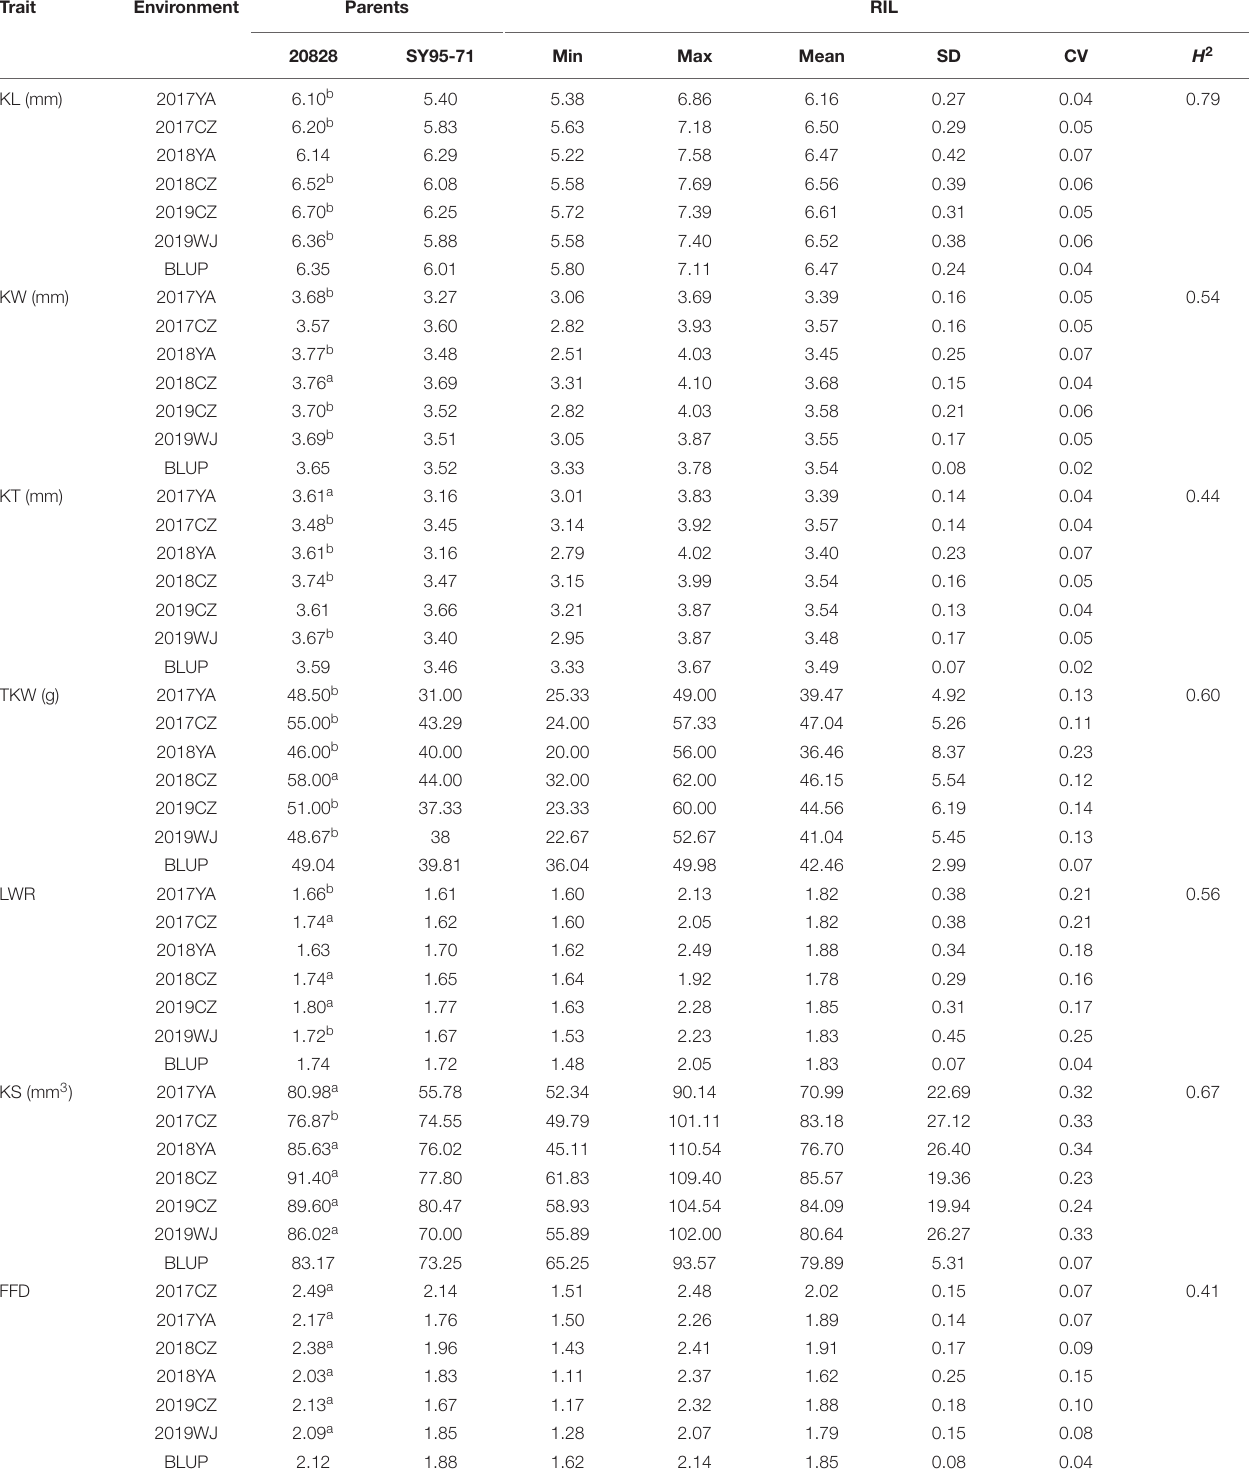
TABLE 1 | Phenotype of the parents and RILs in this study.